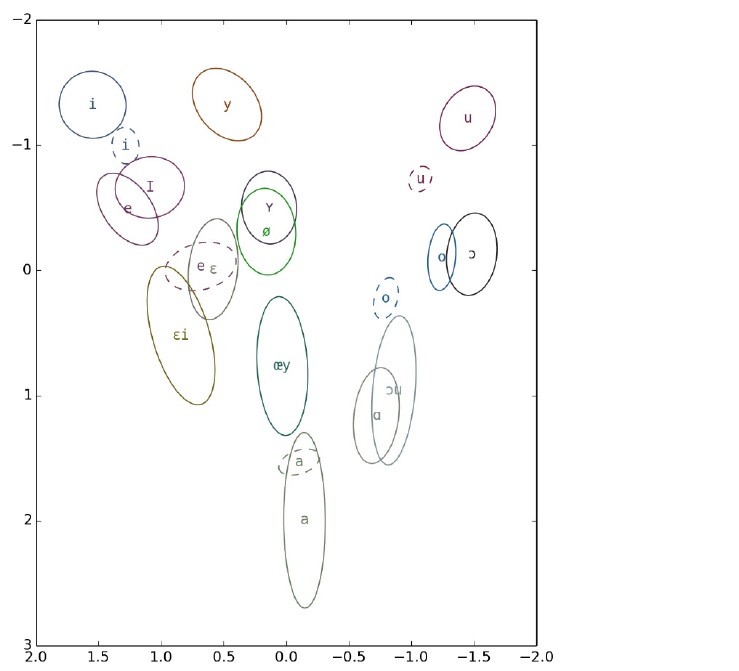
Figure 1. F1 and F2 (normalized) values for the five Spanish vowels (dashed lines), as realized by Spanish L1 speakers and